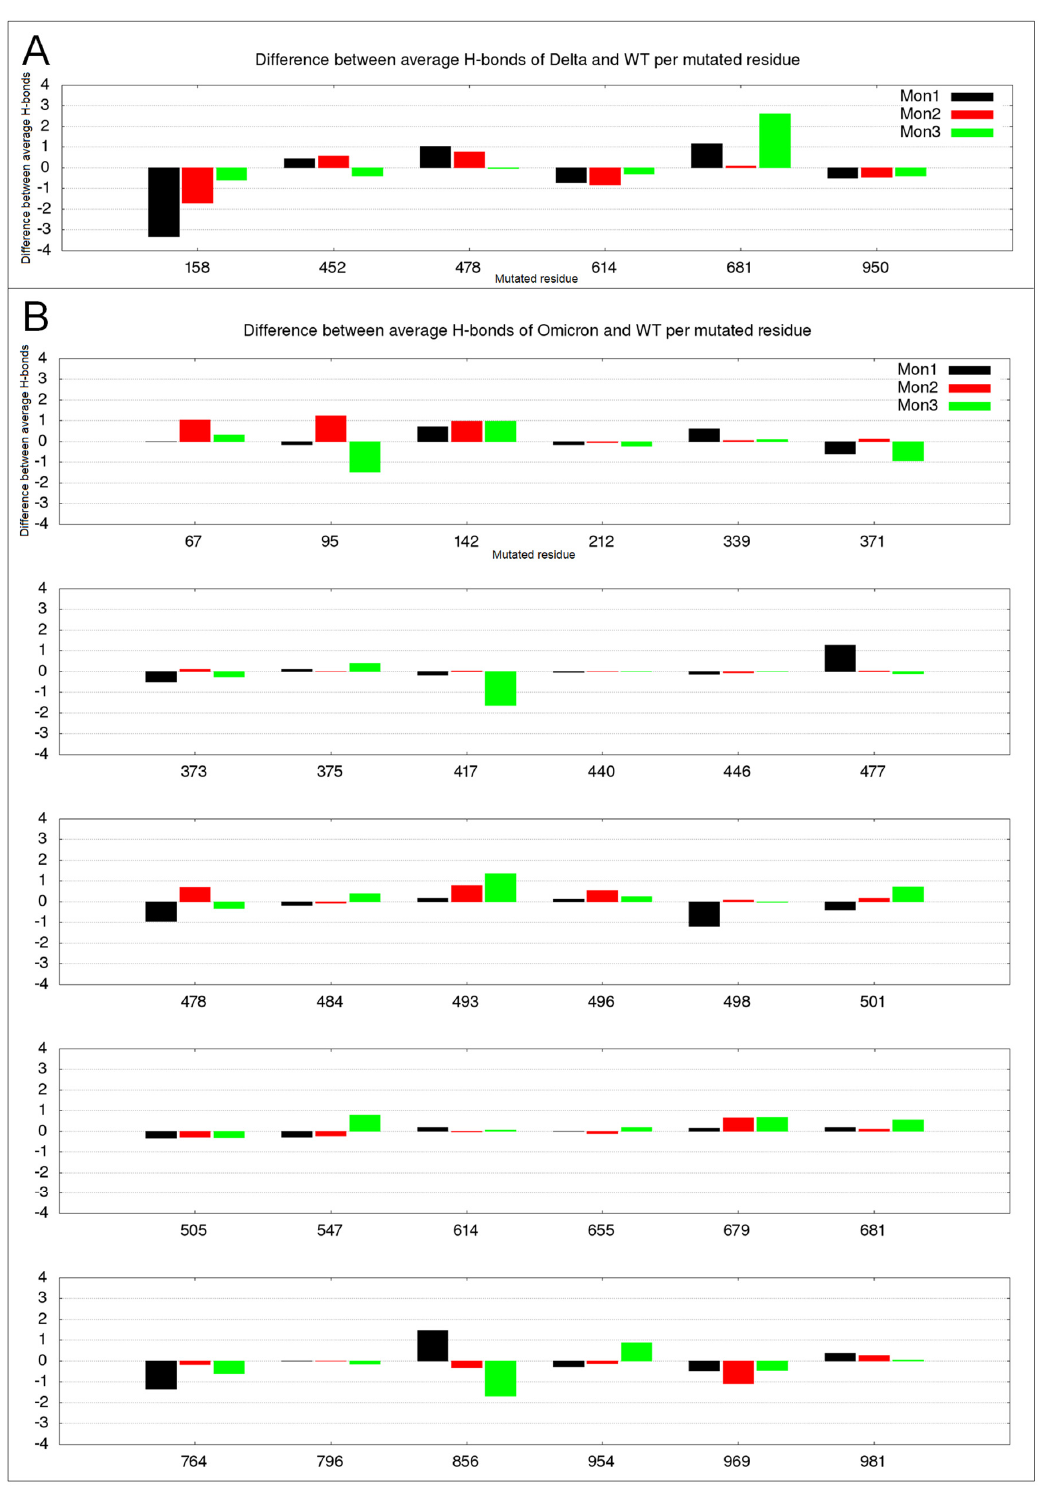
Figure 6. Altered hydrogen bond number in mutated residues. S monomers 1–3 are colored in black, red, and green colors, respectively. ( A ) Differences between the average H-bond numbers in Delta and WT; ( B ) Differences between the average H-bond number in Omicron and WT.